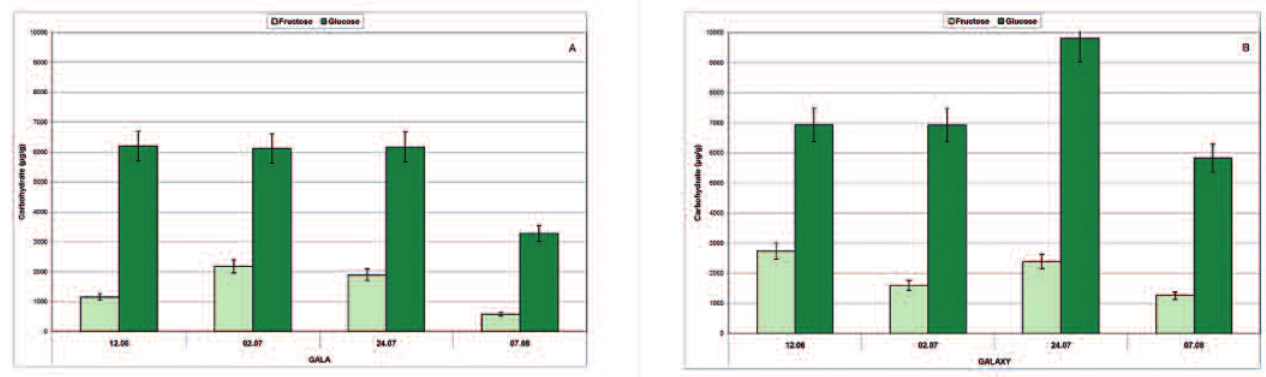
Figure 5. Gála (A) and Galaxy (B) grafted on M26 stock performed sugar reactions in light drought period (June 12 – July 7) as well as in long drought period (July 24 – August 8).